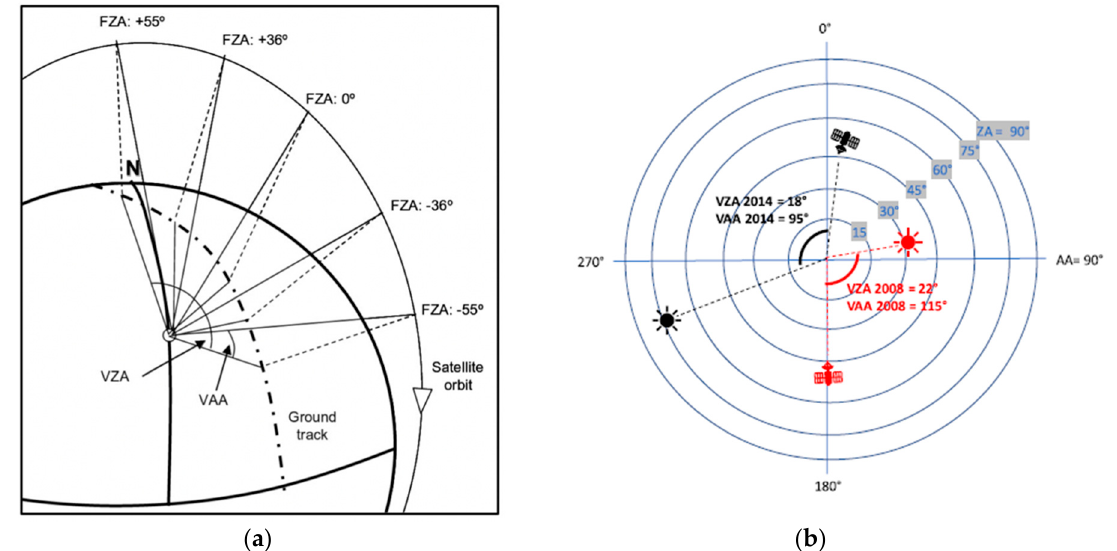
Figure 2. ( a ): Acquisition of nominal angles images in CHRIS/PROBA. FZA: Fly-by-Zenith Angle, VZA: Viewing Zenith Angle, VAA: Viewing Azimuth Angle. ( b ): Viewing geometry of CHRIS/PROBA and the sun for both images over PEMS. AA: Azimuth Angle, ZA: Zenith Angle. Table 2. Properties of the CHRIS/PROBA Mode 4—vegetation product